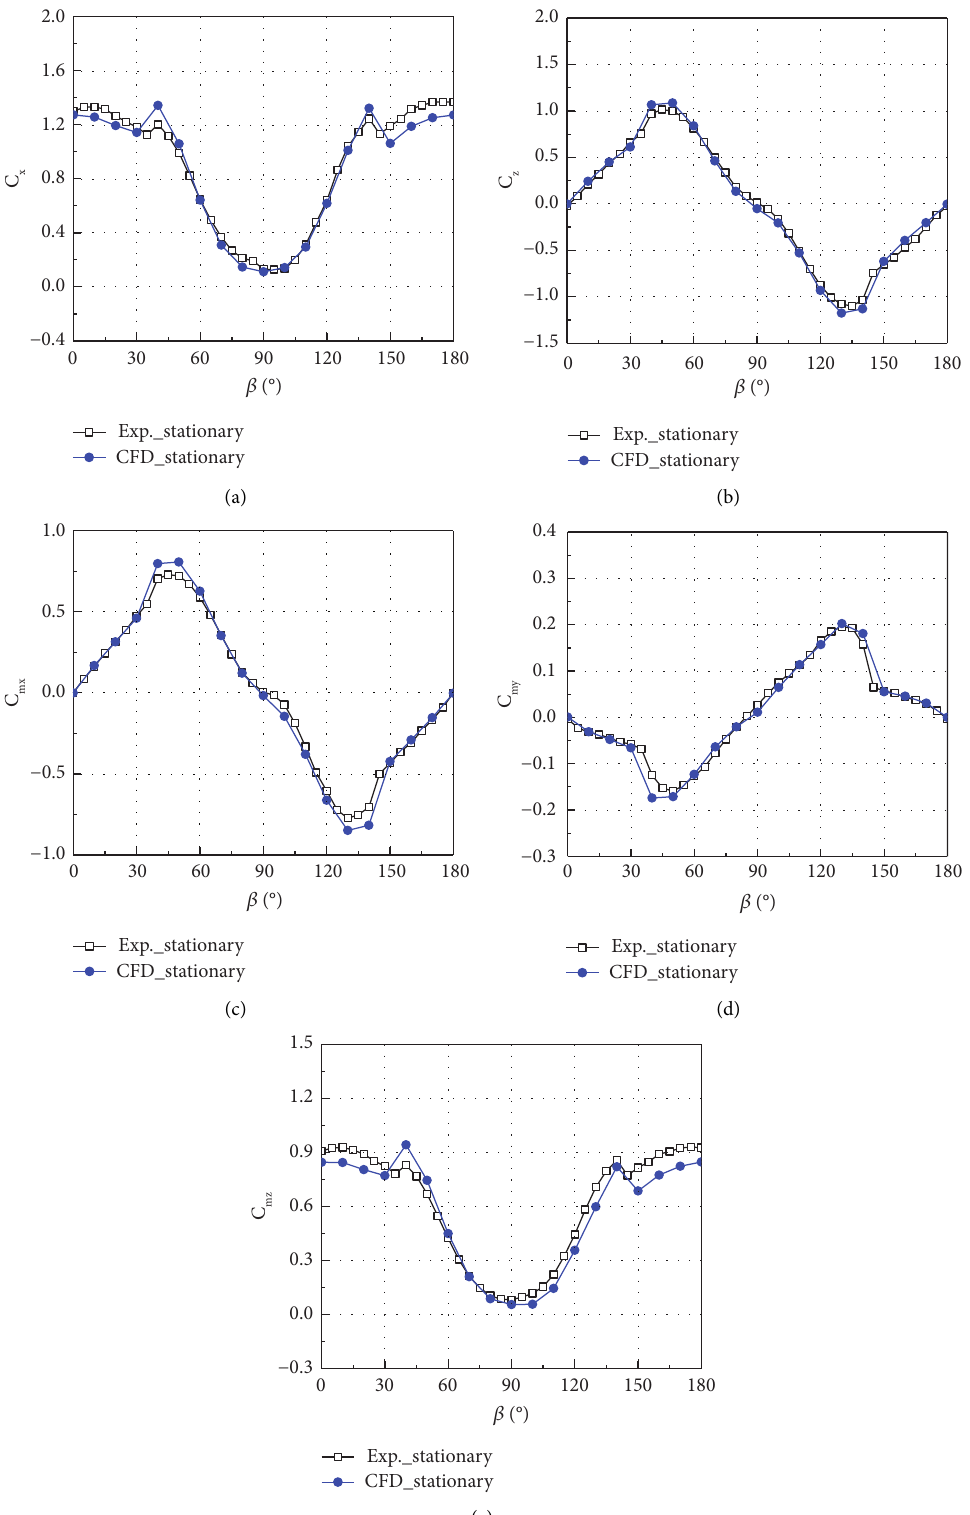
Figure 6: Wind tunnel test results and numerical simulation results of aerodynamic coefficient with respect to the azimuth angle when the antenna is at rest (solid plate, β � 0–180 ° ). (a) C x − β , (b) C z − β , (c) C mx − β , (d) C my − β , and (e) C mz − β